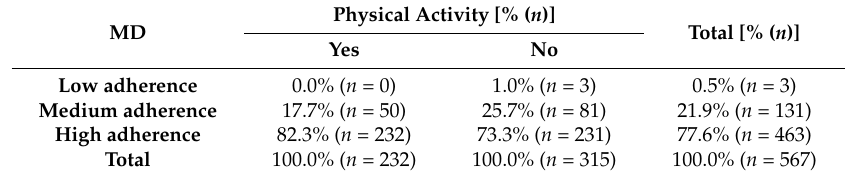
Table 3. Adherence to the MD according to self-reported physical activity level ( p = 0.014).